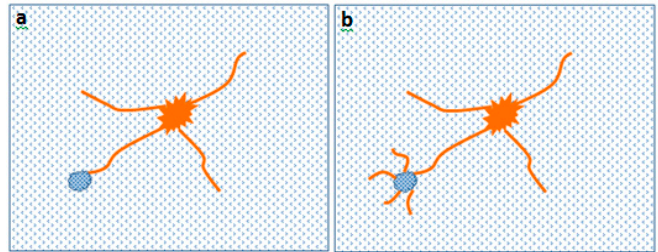
Figure 7. Agglomeration in bamboo composites can either ( a ) stop the damage progression or ( b ) cause more severe damage in the sample.